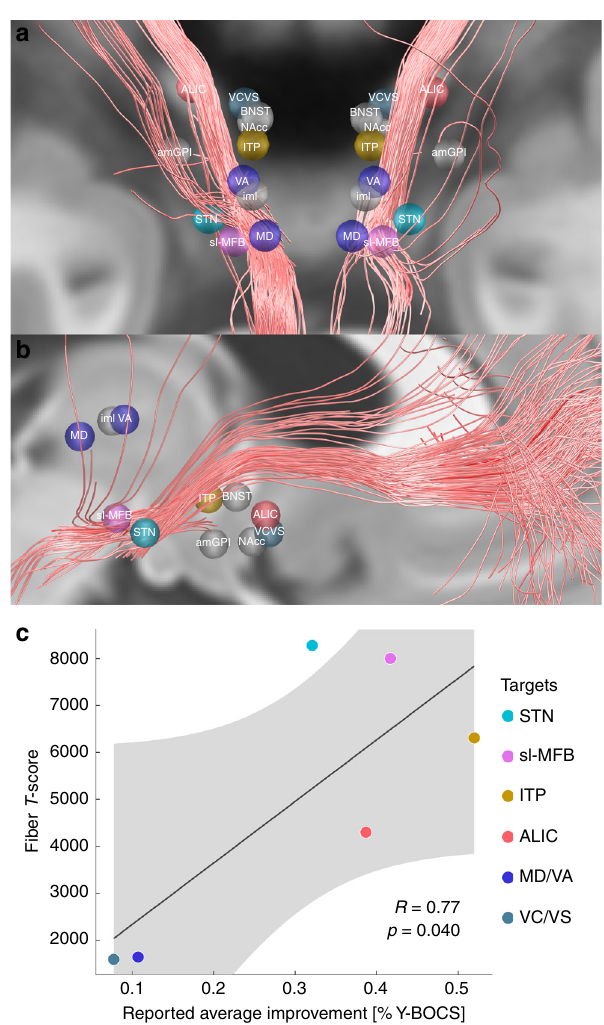
Fig. 5 Literature de fi ned OCD targets in relationship to the identi fi ed tract. Overview of the positively predictive fi ber tracts identi fi ed in the present study are shown in synopsis with DBS targets for treatment of OCD from reported studies. Note that most targets were reported for the tip of the electrode, thus, active stimulation may have occurred dorsal to shown targets (Table 2). a , b Reported average targets mapped to standard space. c The degree of weighted overlap between stimulation sites and the identi fi ed tract. These were correlated with reported average %-Y-BOCS improvements of published studies (where available, other sites marked in gray; see Supplementary Methods for details). Gray shaded area represents 95% con fi dence